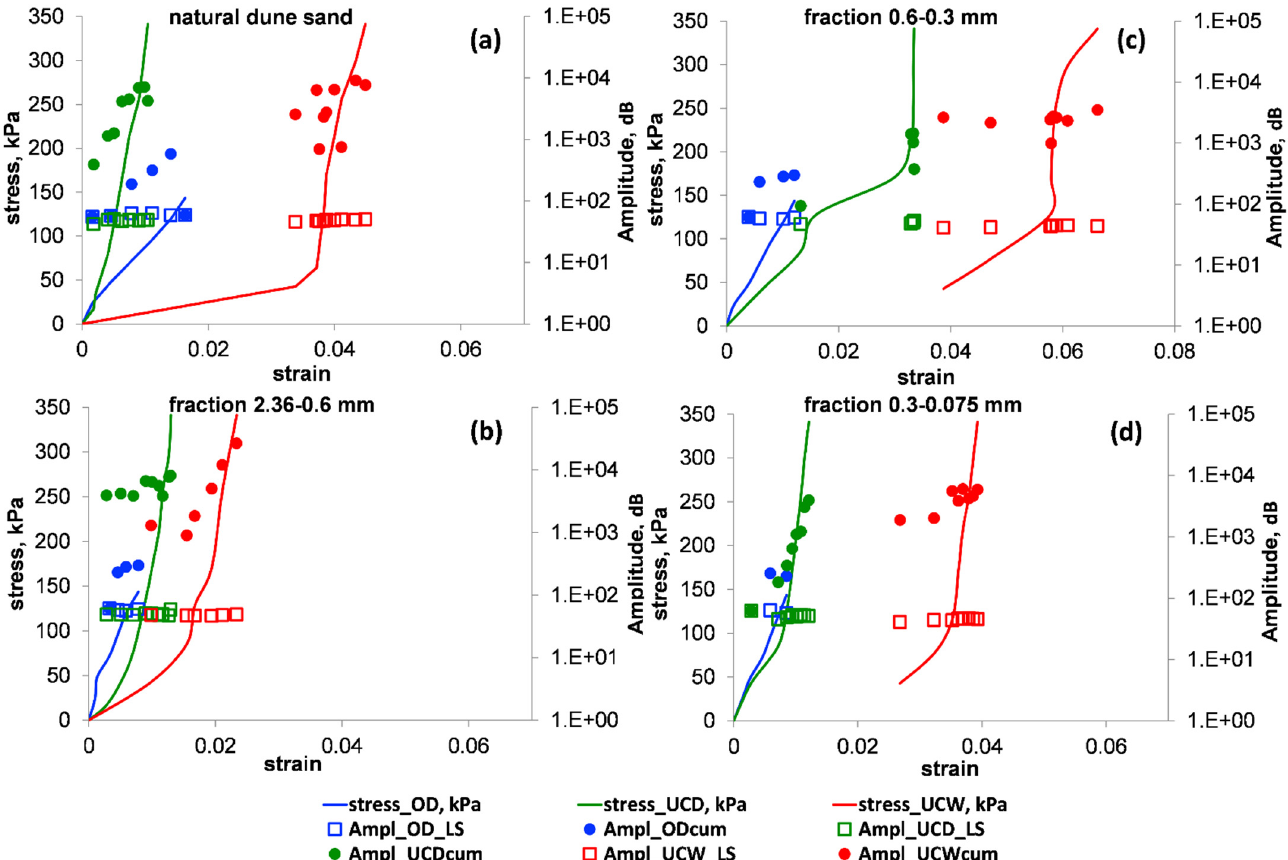
Figure 12. The stress–strain relationships (solid curves) vs. the values of the signal amplitude (Ampl) for the OD (blue), UCD (green) and UCW (red) tests. The empty squares and the full circles denote the values of the average (index = LS) and cumulative (index = cum) signal amplitudes for a loading stage, respectively. Panels ( a – d ) show the results for natural dune sand and its three extracted fractions: 2.36–0.6, 0.6–0.3 and 0.3–0.075 mm, respectively. Note that in the used number format, the notation “E ± xx” is part of a scientific notation and corresponds to “ · 10 ± xx